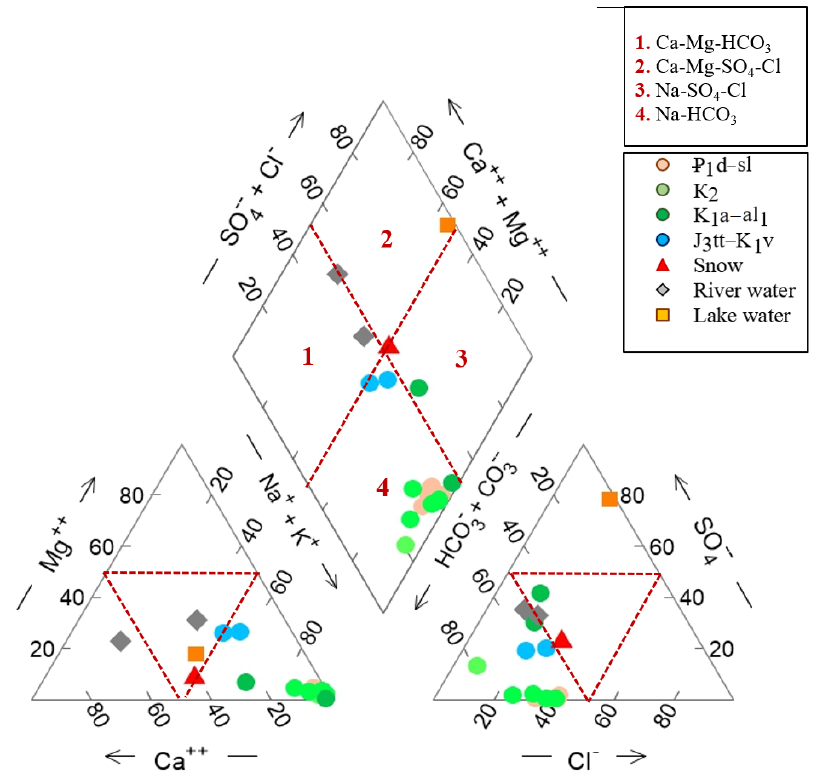
Figure 5. Piper diagram of water samples.